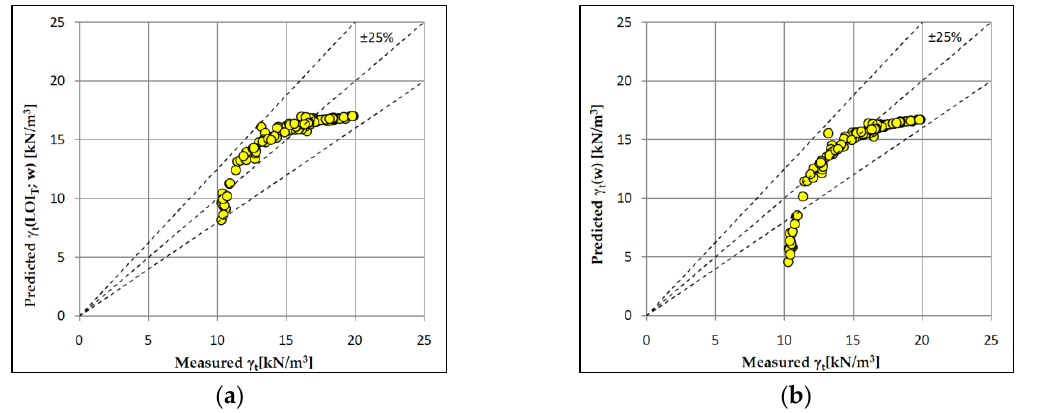
Figure 10. Comparison between measured values of soil unit weight and the values expected, based on regression analysis, including the model with ( a ) two independent variables ( w ; LOI T ) and ( b ) one independent variable ( w ).